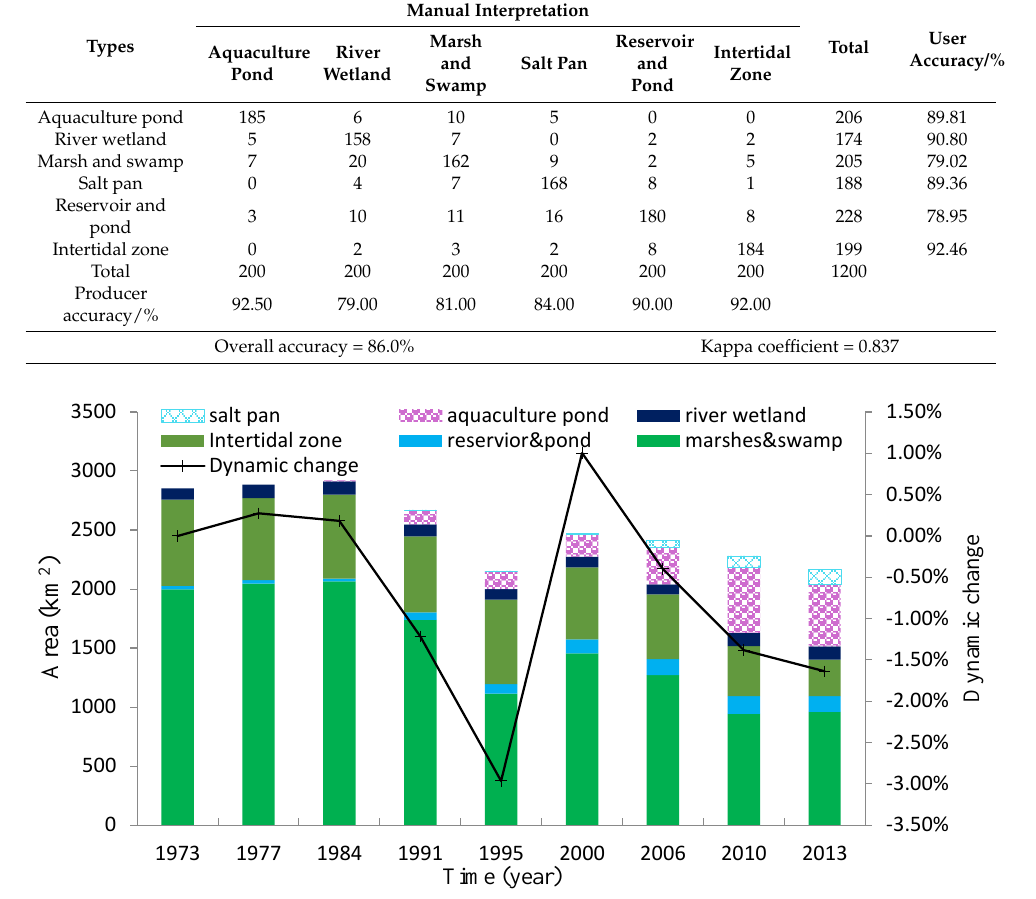
Figure 5. Accumulation histogram of area and dynamic change for all types of wetlands through time. Table 5. Wetland area by type in the Yellow River Delta at different periods from 1973 to 2013 (units: km 2 ).